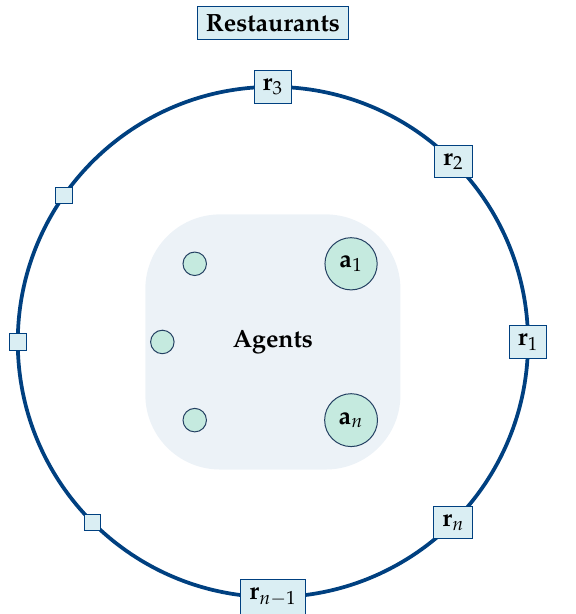
Figure 1. In the original formulation of the KPRP, the above topology is assumed implicitly.